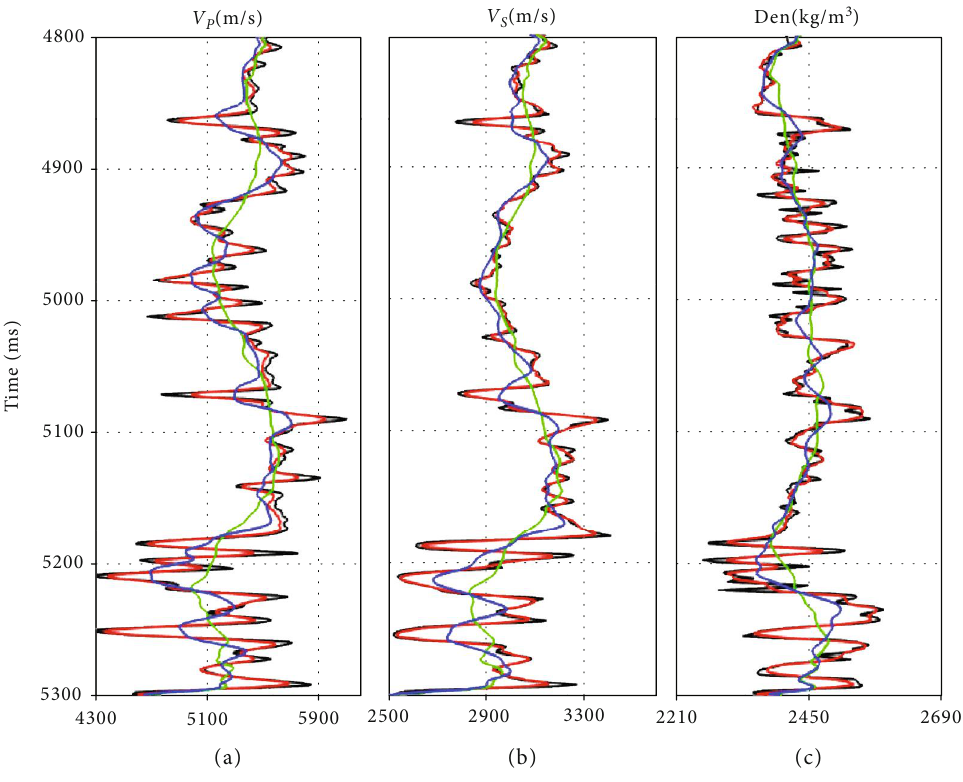
Figure 2: Synthetic test of the di ff erent prestack inversion methods. The black solid line represents the real data; the green solid line represents the initial model; the blue line represents the Aki approximate equation inversion result; the red line is the exact Zoeppritz equation prestack inversion